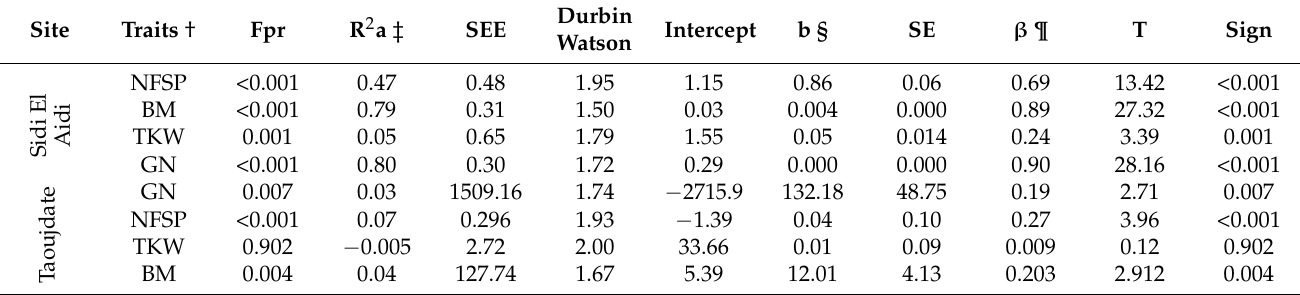
Table 4. Regression model analysis for ground cover prediction estimation of yield and yield